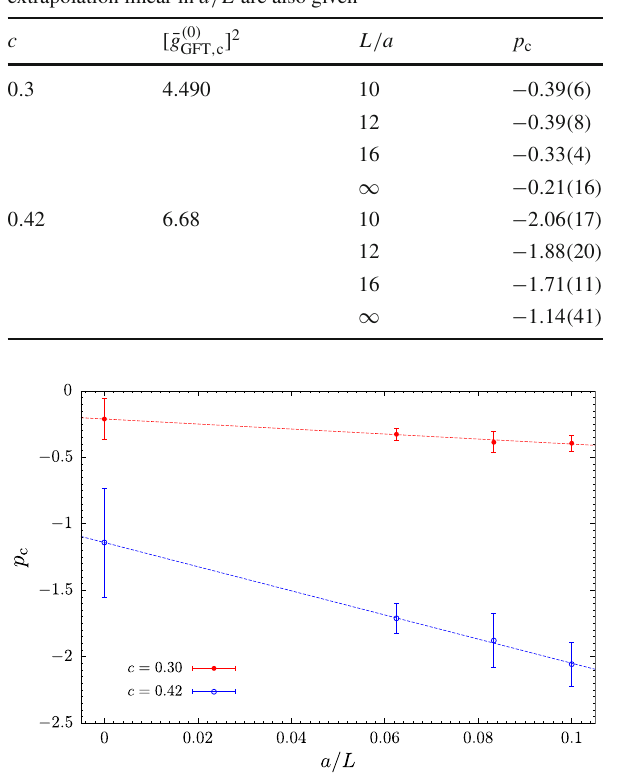
Putting the numbers together we obtain for the LO estimate, Eq.